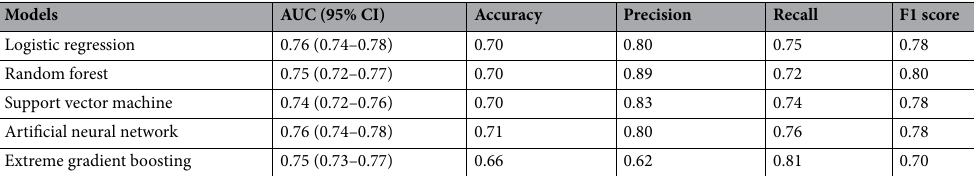
Models AUC (95% CI) Accuracy Precision Recall F1 score Logistic regression 0.76 (0.74–0.78) 0.70 0.80 0.75 0.78 Random forest 0.75 (0.72–0.77) 0.70 0.89 0.80 Support vector machine Artificial neural network 0.76 (0.74–0.78) Extreme gradient Table 2. Performance comparison of the machine learning models in the testing set. AUC, area under the receiver operating characteristic curve; CI, confidence interval.